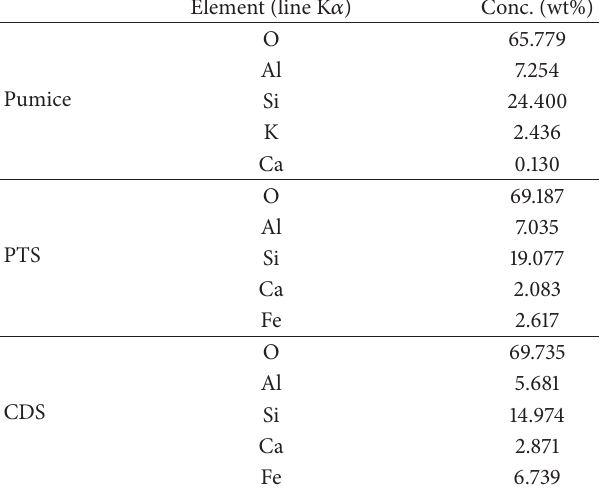
Table 2: Qualitative and quantitative analysis for pumice